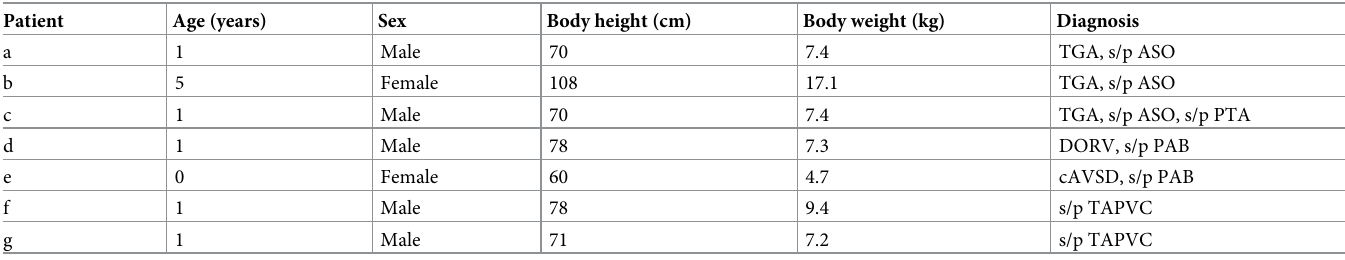
Table 1. Patient demographic data.